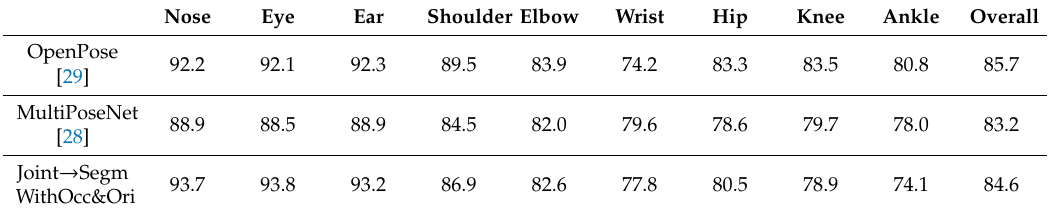
Table 5. Comparison between proposed model and other methods using PCK (%).